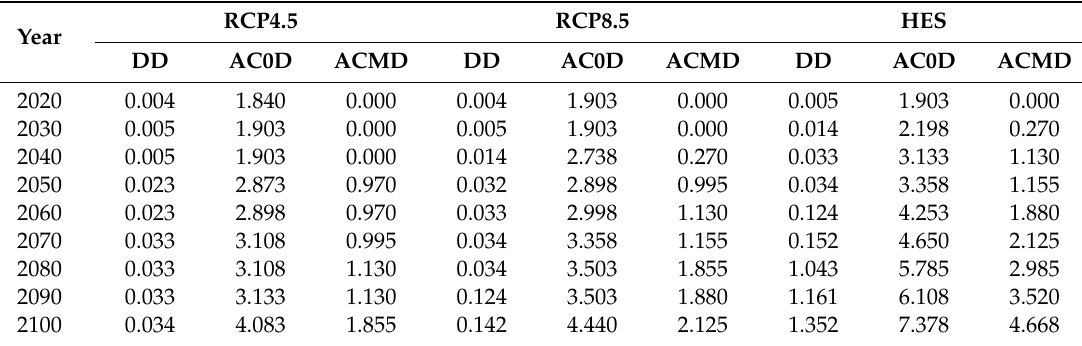
Table 2. Damage and adaptation costs (in M € ) for TR = 5 years. DD: Direct damages; AC0D: adaptation costs with 0 damage; ACMD: adaptation costs with minimum